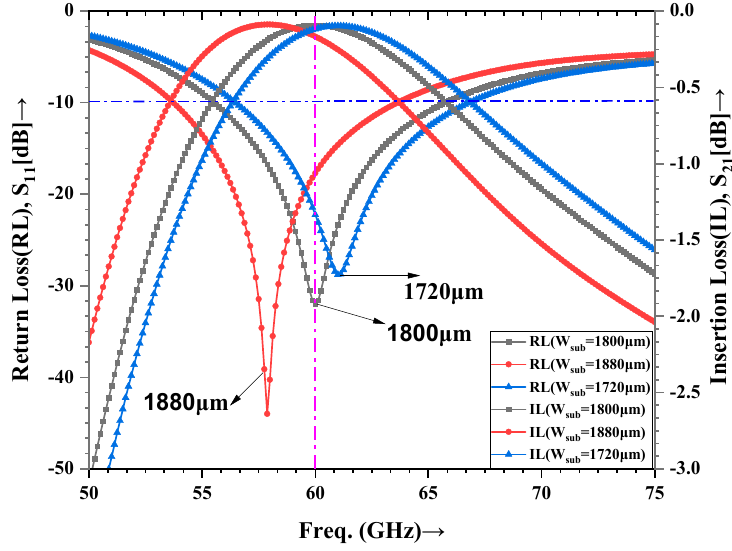
Figure 3. Effect of variations of substrate width on RL and IL plots.